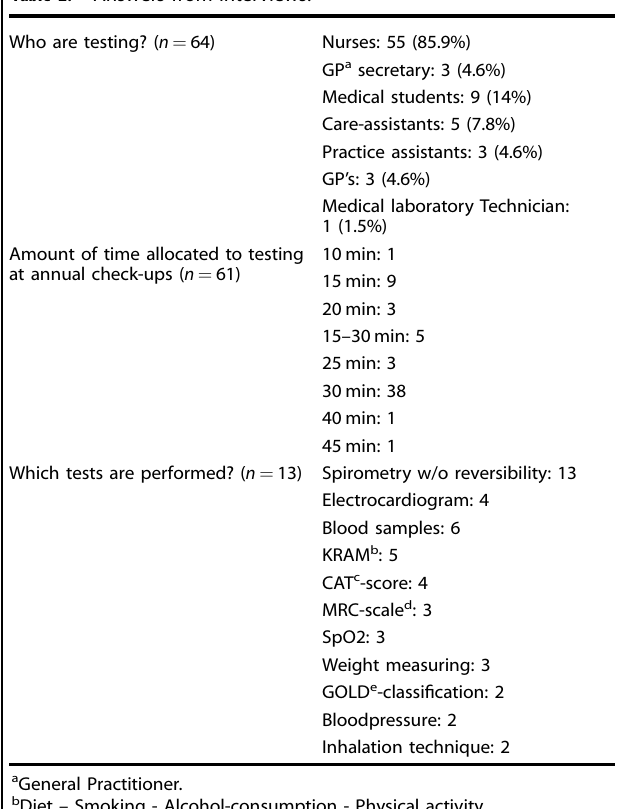
Table 2. Answers from